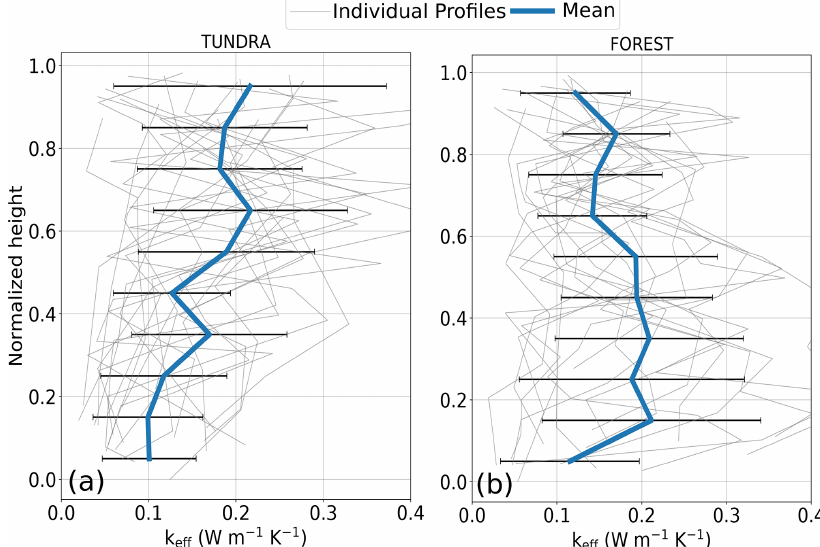
Figure 7. Same as Fig. 6 but for snow thermal conductivity ( k eff ). Note that only data from 21 snow pits for TUNDRA and 17 for FOREST were used as thermal conductivity measurements were not collected for every snow pit. The mean of all profiles is also shown, together with the standard